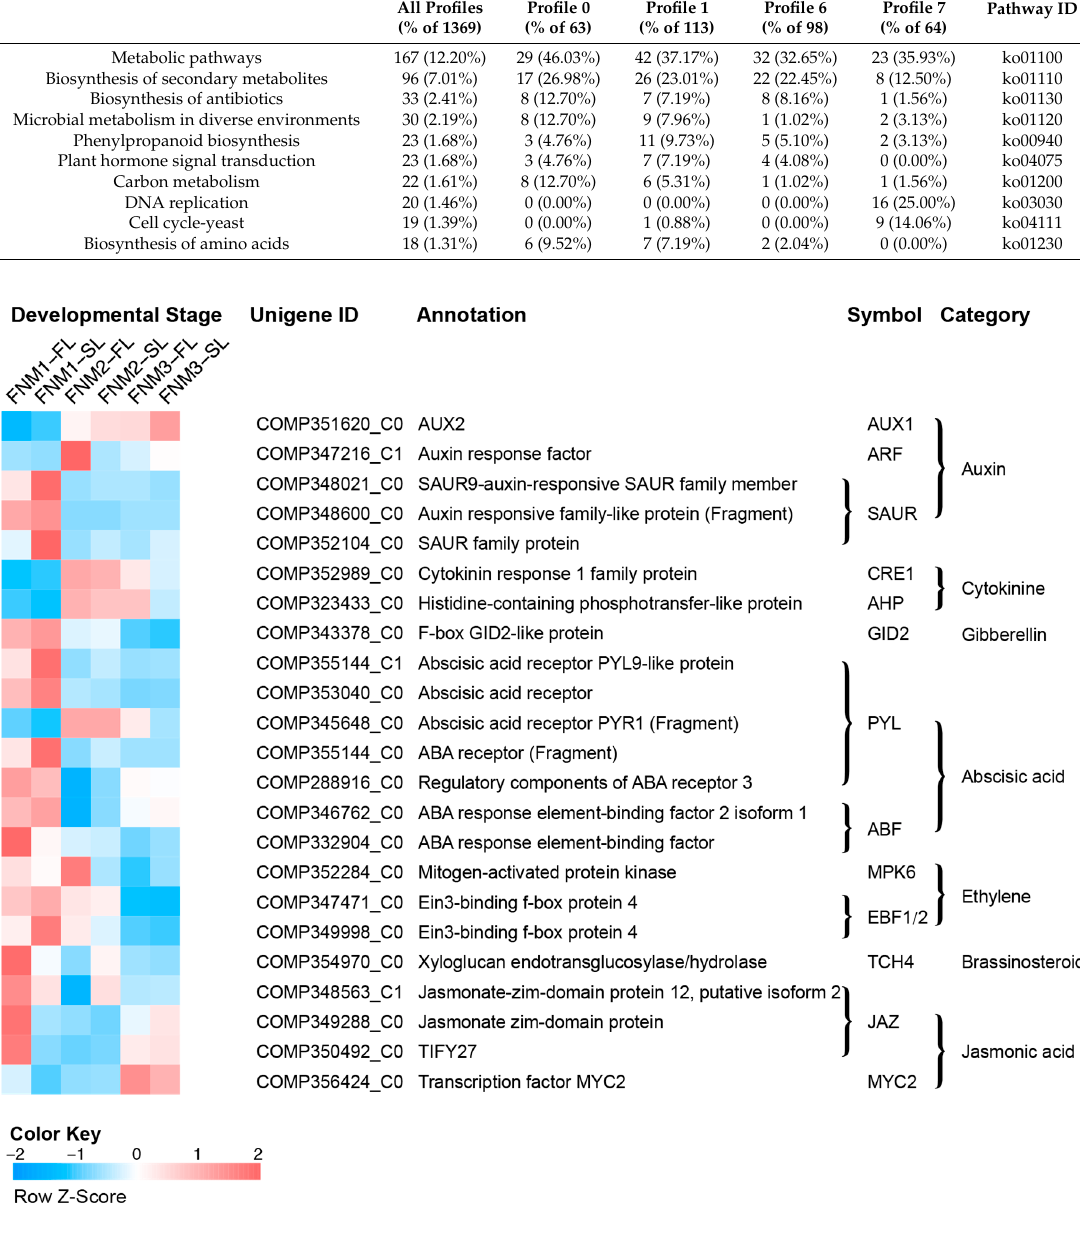
Figure 6. Heat map diagram of expression levels of DEGs annotated in the plant hormone signal transduction pathways analyzed by KEGG. Data for the gene expression level were normalized to Z-score.